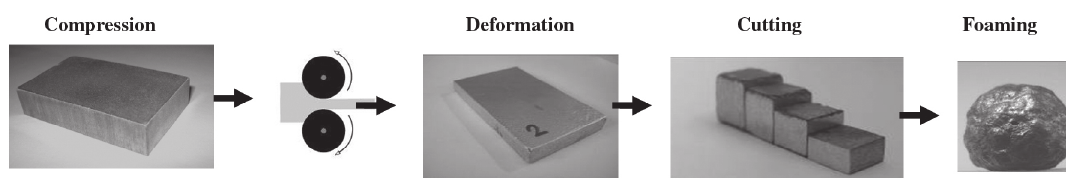
Figure 2. Production stages of spherical-shaped aluminum